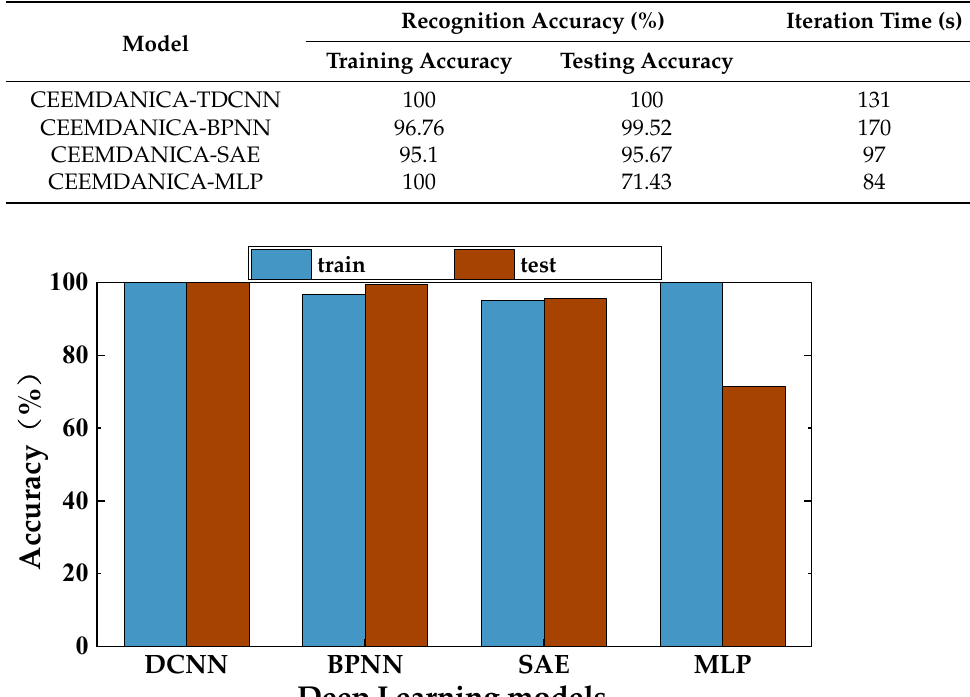
Table 4. Recognition results of different deep learning models.